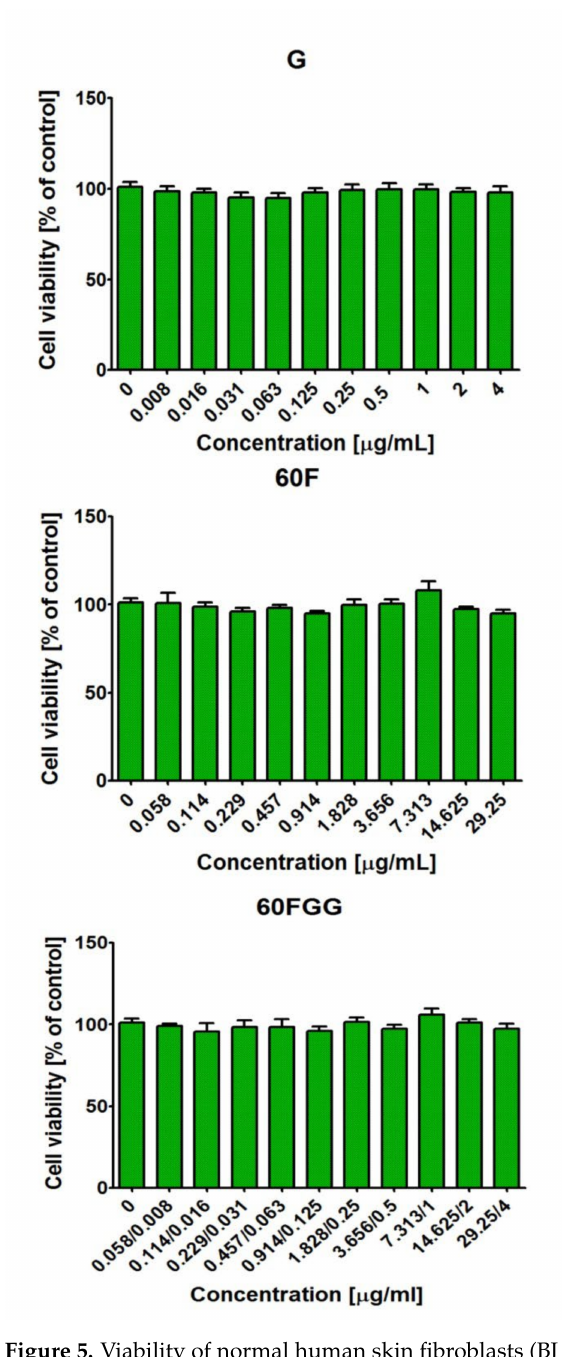
Figure 5. Viability of normal human skin fibroblasts (BJ cell line, CRL-2522 TM ) after 24 h treatment with aqueous solutions of gentamicin sulfate salt ( G ), C 60 fullerenol ( 60F ), and gentamicin function- alized C 60 fullerene ( 60FGG ). Gentamicin ( G ) was evaluated at concentration of 4–0.008 µ g/mL, C 60 fullerenol ( 60F ) at concentration of 29.25–0.058 µ g/mL, while concentrations of gentamicin and C 60 fullerenol in obtained conjugate ( 60FGG ) ranged from 4–0.008 µ g/mL and 29.25–0.058 µ g/mL, respectively. The cell viability was assessed by MTT assay. The results were not statistically sig- nificant ( p > 0.05) compared to control, namely cell incubated with culture medium without tested compounds; one-Way ANOVA test, followed by a Tukey’s multiple comparison